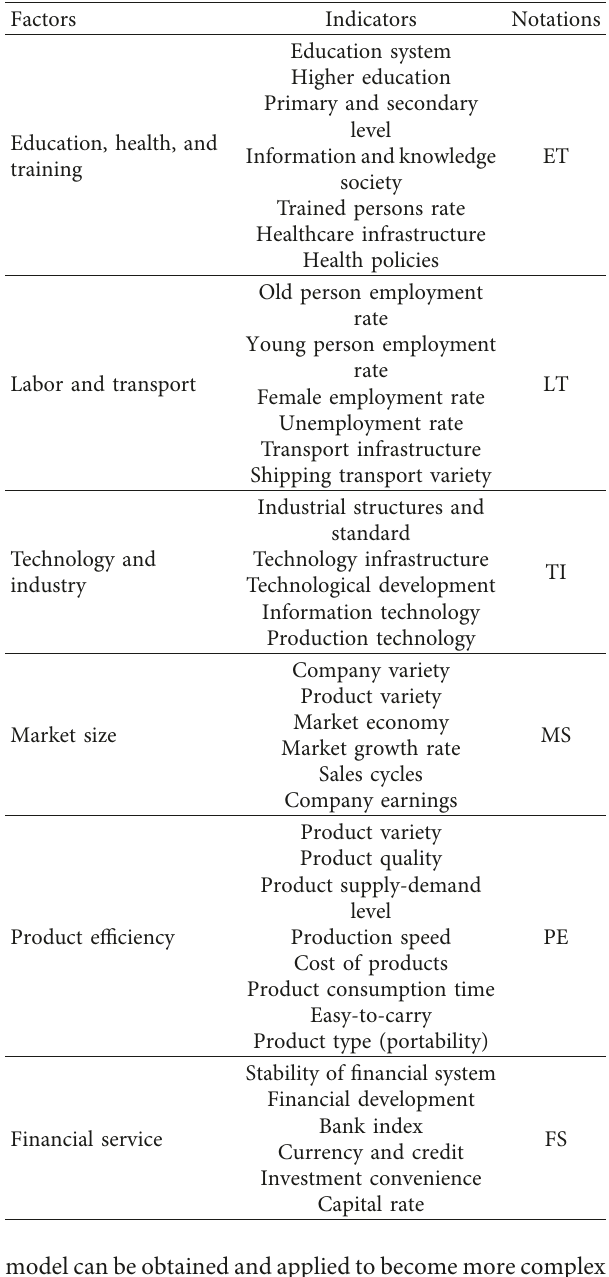
Table 1: Indicators of the affecting factors of